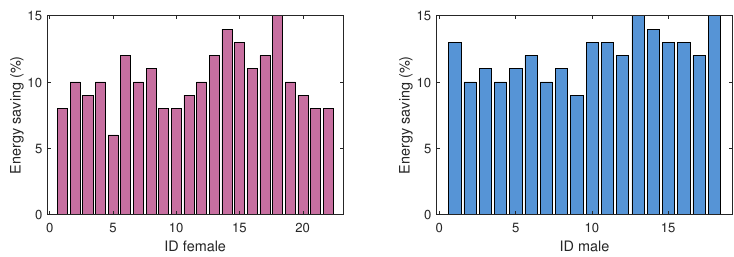
Figure 18. Energy saving (%) with algorithm in male- and female-occupied houses.